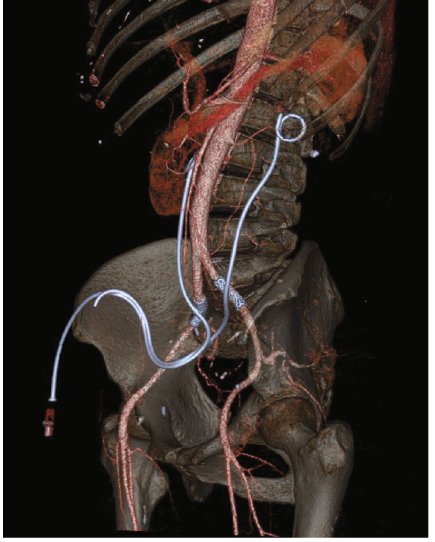
Figure 3: Three-dimensional abdominal CT scan that demonstrated bilateral iliac artery endoprosthesis and ureteral stents (sagittal